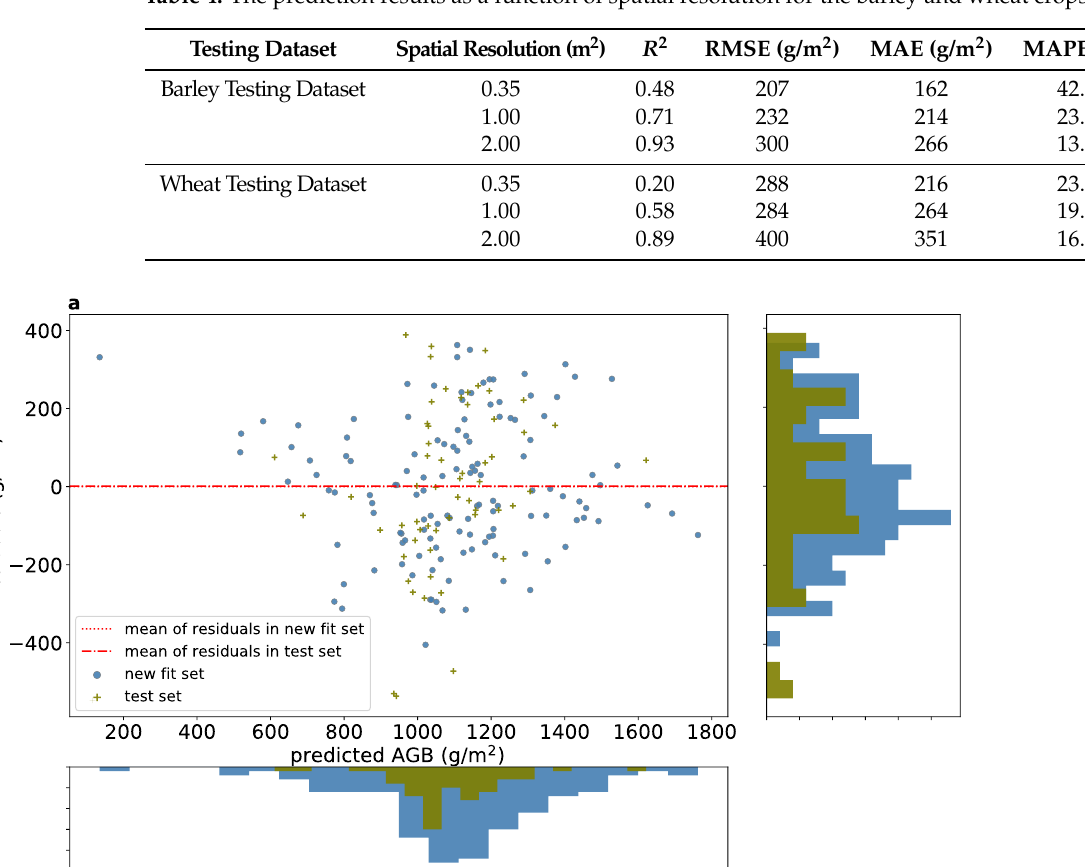
Table 4. The prediction results as a function of spatial resolution for the barley and wheat crops.